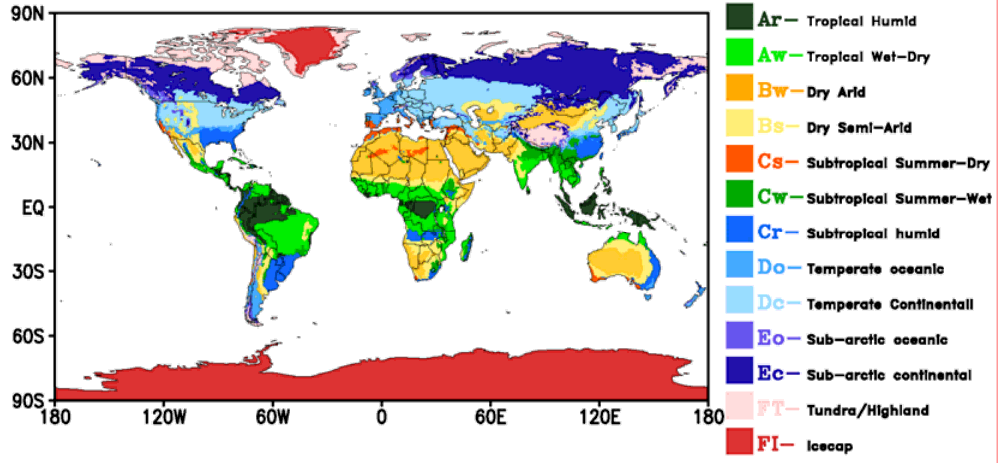
Figure 2. The derived Köppen-Trewartha (K-T) climate classification based on the 30-year mean of the CRUv3.0